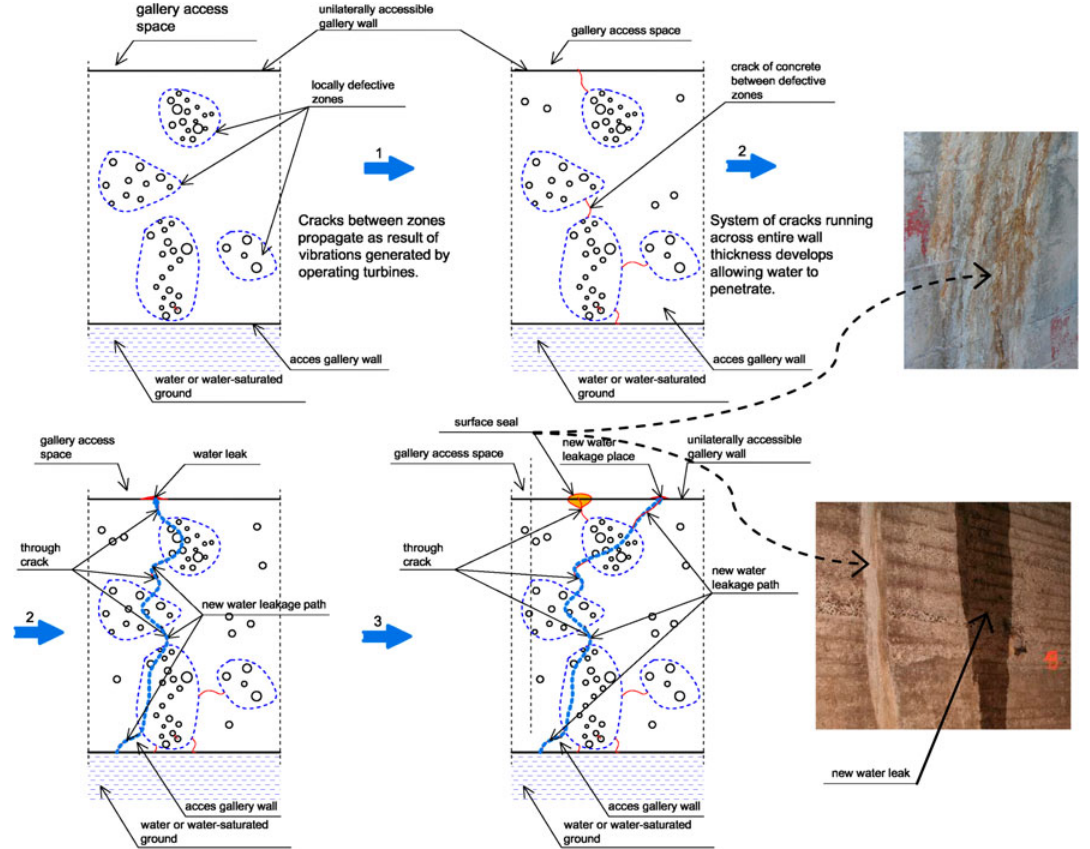
Fig. 1. Hydroelectric power plant access gallery and illustration of how water leaks through its walls